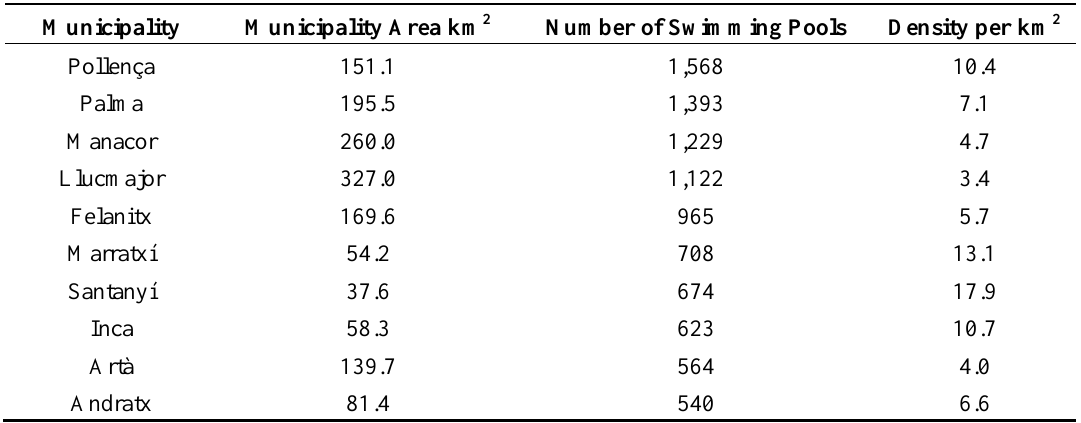
Table 2. Swimming pool distribution in the countryside in Majorca, by municipalities. Data source: 1:5,000 Topographic Map of the Balearic Islands